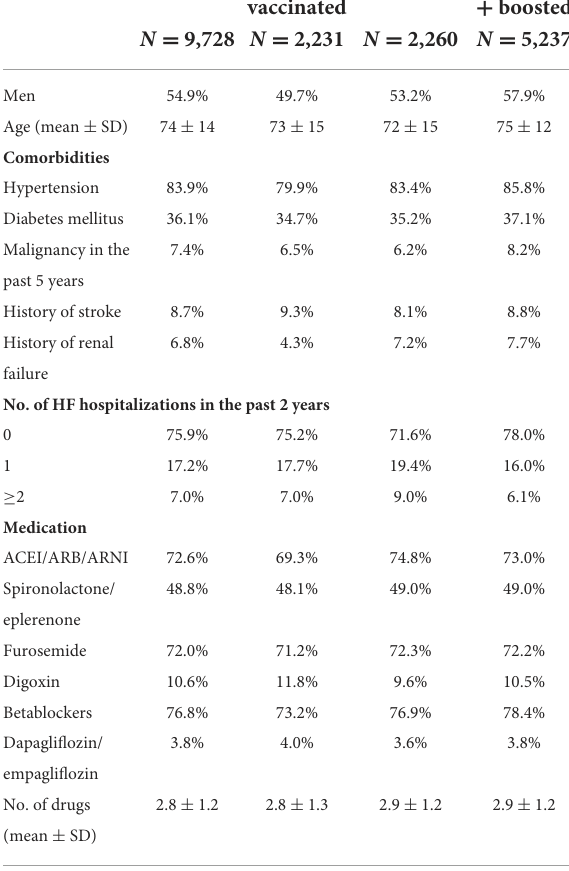
algorithm for selection of independent predictors of COVID-19- related hospitalization and ICU admissions.